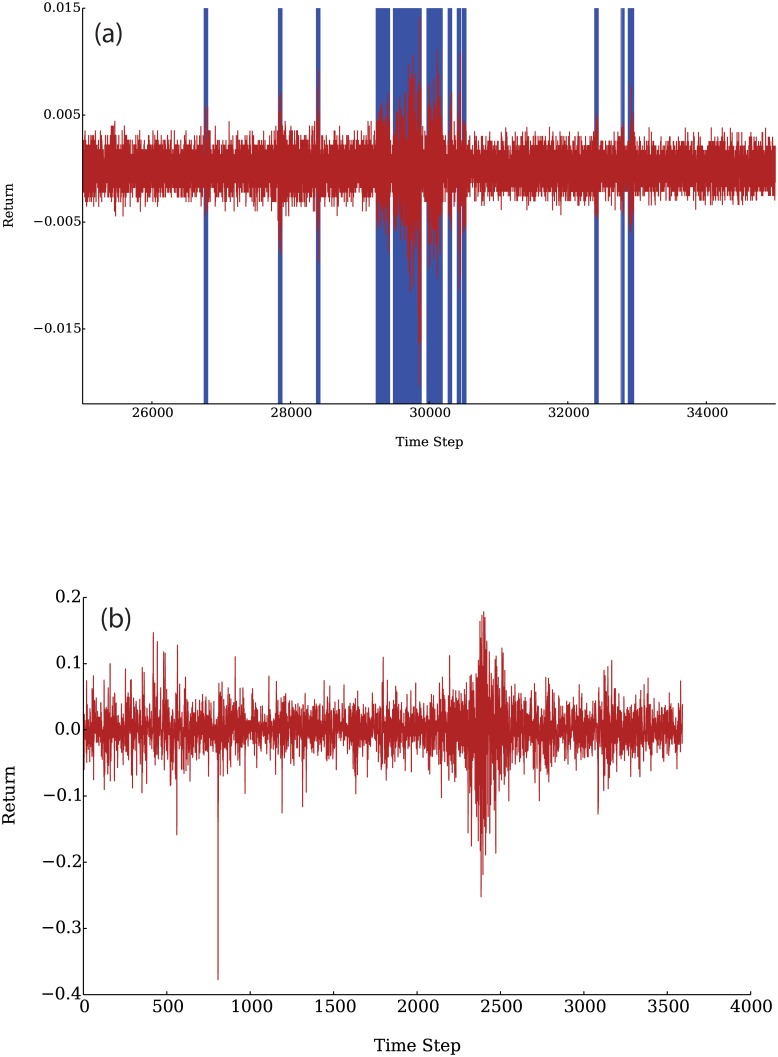
Returns time series for the simulation with a time lag τ = 1 (a) and comparison with empirical data from Consol Energy Inc (b).The blue shaded regions show the times in which technical agents were active, as can be seen, these times coincide with the periods with the largest changes of price. Data obtained from QuantQuote [43].